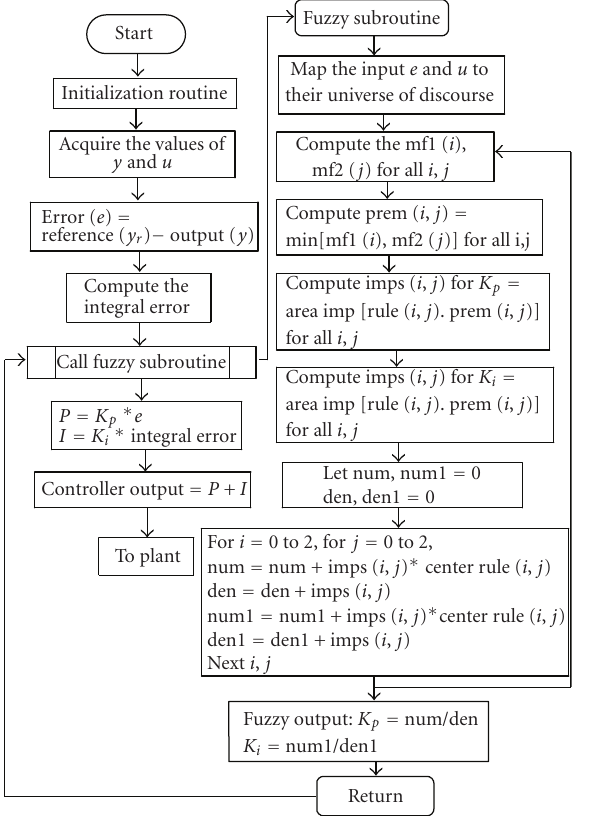
Figure 8: Flow chart of the various steps in the development of fuzzy-coordinated PI control algorithm.